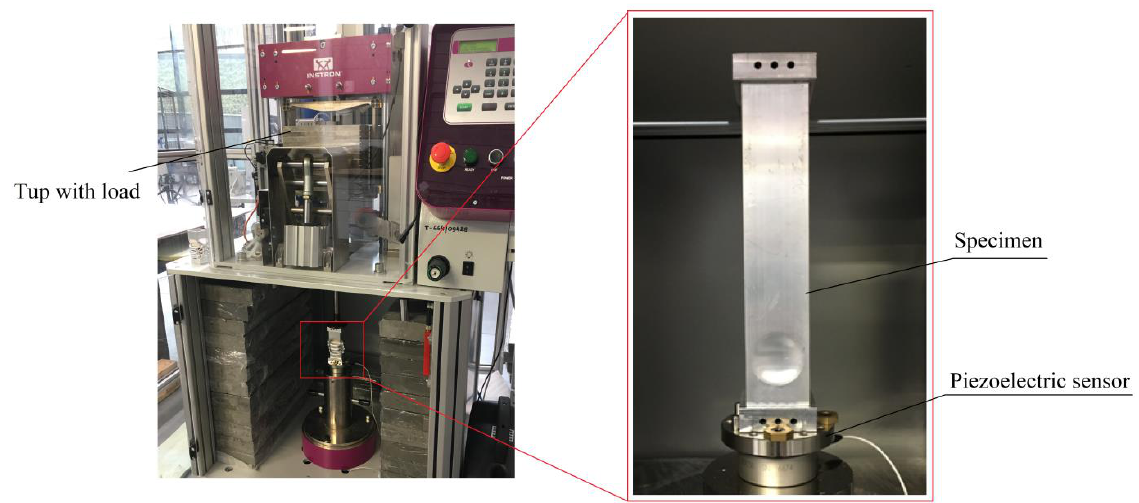
Figure 6. General appearance of the experimental test station and specimen